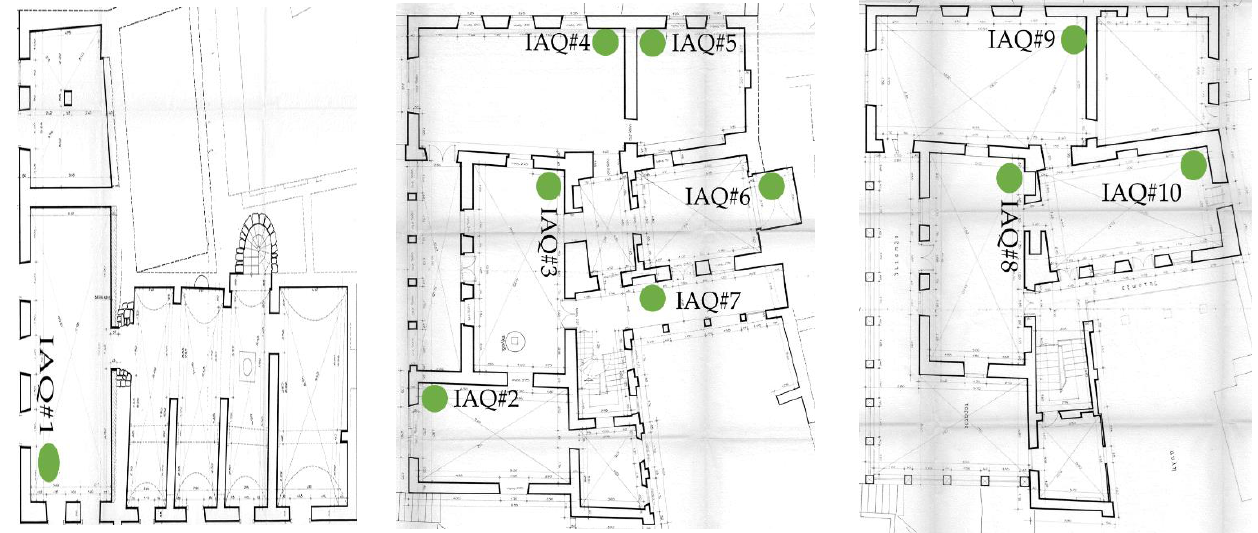
Figure 2. Selected experimental points within the museum. From left to right: ground floor, 1st floor, 2nd floor. One sensor (IAQ#1) was placed in the Auditorium Hall of the ground